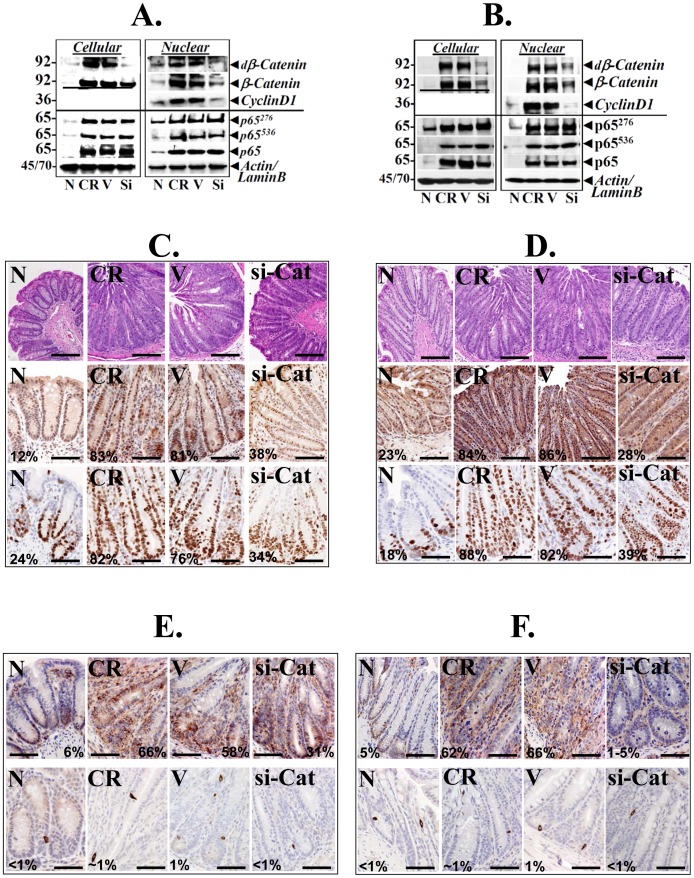
Signaling via β-catenin is integral to crypt hyperplasia.CR-infected wild type C57Bl/6 (A) and Tlr4−/− (B) mice either received vehicle (V) or ip injections of nanoparticle-encapsulated β-catenin siRNA (Si) every alternate day for 10 days. Colonic crypts were isolated and subjected to cellular or nuclear extract fractionation followed by Western blotting for indicated proteins. Actin and LaminB were used as loading controls. C–F. Paraffin embedded sections prepared from the distal colons of uninfected normal (N), CR infected (CR), CR infected+vehicle treated (V) or CR infected+β-catenin siRNA treated (si-Cat) mice were stained with: C and D. H&E for gross morphology (upper panel), β-catenin phosphorylated at Ser-552 to detect active β-catenin (middle panel) and Ki-67 for proliferation (lower panel); E and F. CD44 (upper panel) and Dclk1 (lower panel) were also stained to determine the effect of β-catenin knockdown on stem cells. Percentages represent percent cells positive for indicated markers. Scale bar: 125 µm; n = 2 independent experiments.